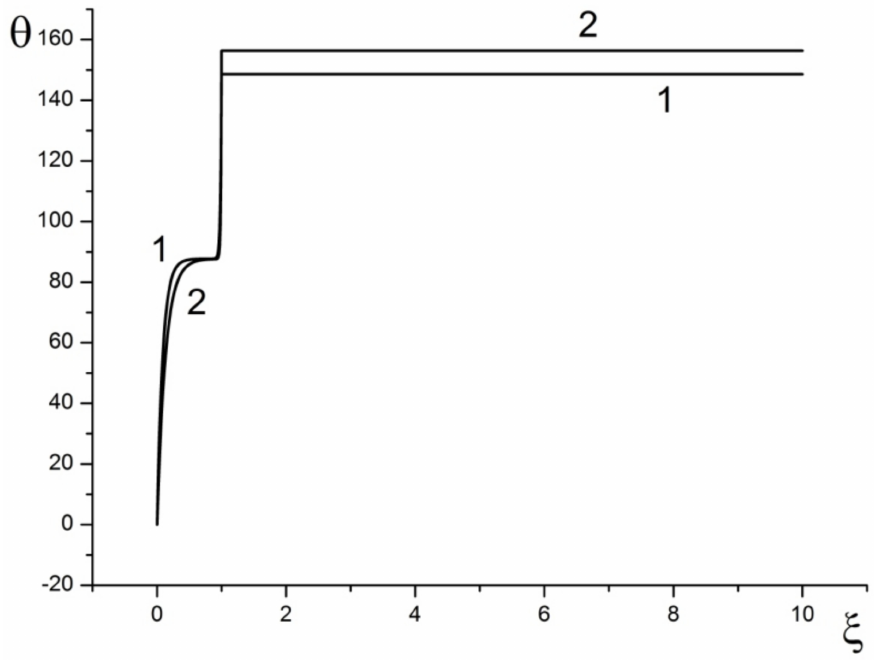
Figure 8. Solutions in the case of non-monotonic critical curve. Approximate model (29). A = 2.75 × 10 − 18 ; Ar = 0.012; h s = 7.14 × 10 2 ; µ = 75.0; g = 1.22 × 10 − 20 ; θ s = 87.70; 1—Pe = 50.0; 2—Pe =